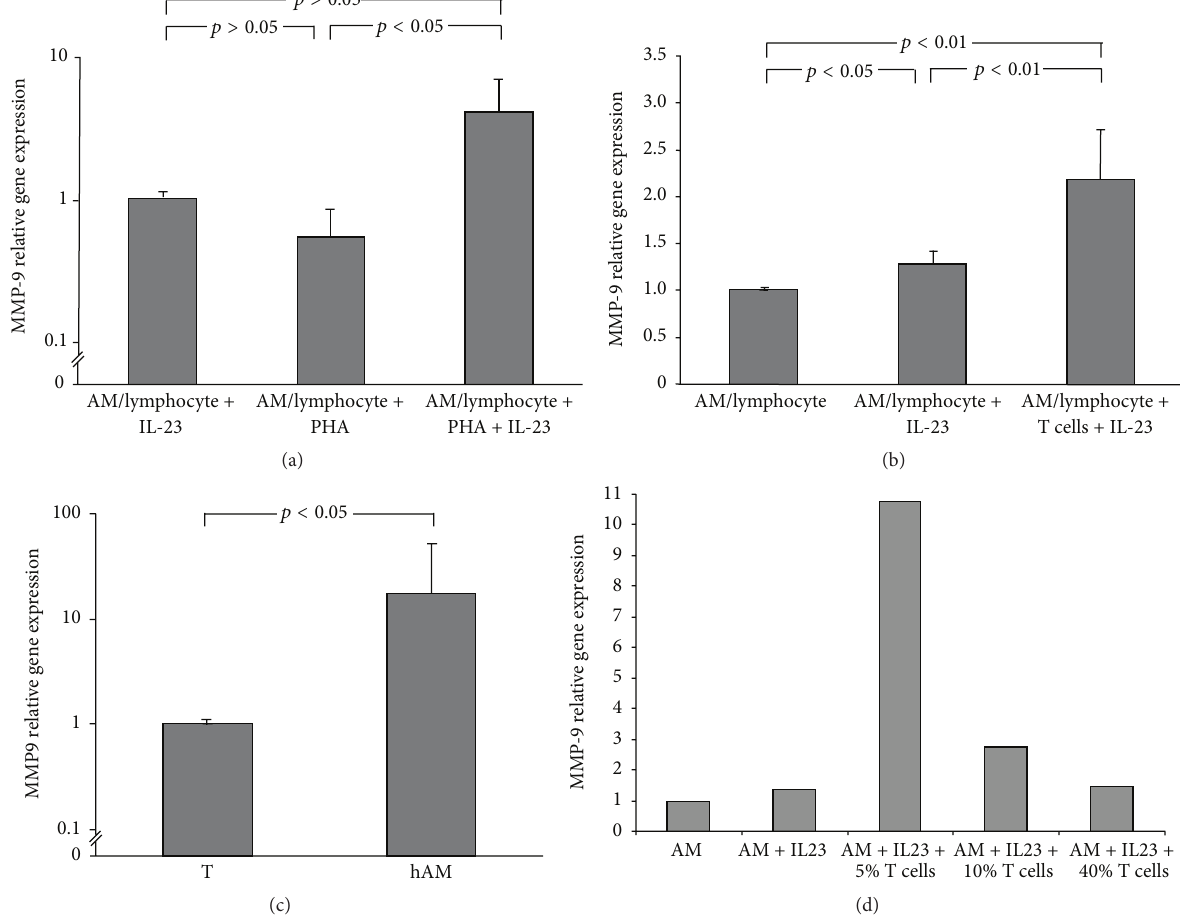
Figure6:TheroleofTcellsinAM/lymphocytecoculturesinIL-23inducedMMP-9upregulation.(a)AM/lymphocytecoculturestreatedwith lymphocyte mitogen PHA (20 𝜇 g/mL) respond to IL-23 (10ng/mL) in a stronger fashion compared to AM/lymphocyte cocultures stimulated with IL-23 only ( 𝑛 = 4 , mean ± SEM, 𝑝 < 0.05 , Kruskall-Wallis). (b) Purified T cells from lavage (isolated via rosetting with neuraminidase treated sheep RBCs) added to AM/lymphocyte cocultures contribute to stronger upregulation of MMP-9 upon IL-23 cytokine stimulation ( 𝑛 = 6 , mean ± SEM, 𝑝 < 0.01 , ANOVA). (c) AM expression of MMP-9 in comparison to its expression in T cells from BAL. T cells were purified from lavage using CD2 magnetic beads and relative expression of MMP-9 was compared by TaqMan PCR ( 𝑛 = 11 , mean ± SEM, 𝑝 < 0.05 , Wilcoxon Signed-Rank Test). (d) The effect of T cells on potentiation of MMP-9 upregulation after IL-23 stimulation (10ng/mL) of AM/lymphocyte cocultures falls as the number of T cells increases (T cells percentage in AM cultures: 5%, 10%, and 40%; representative results of the effects seen in 4